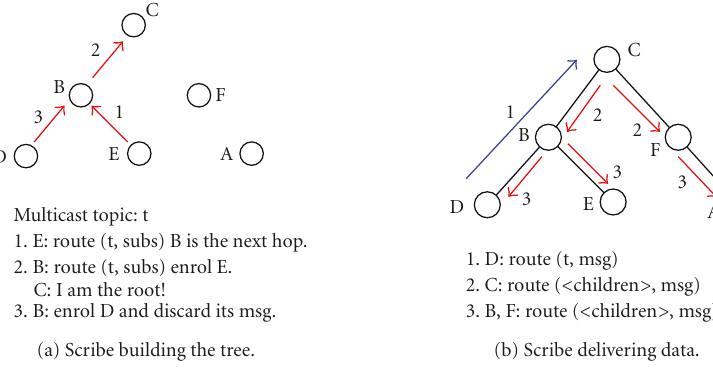
Figure 2: Scribe main